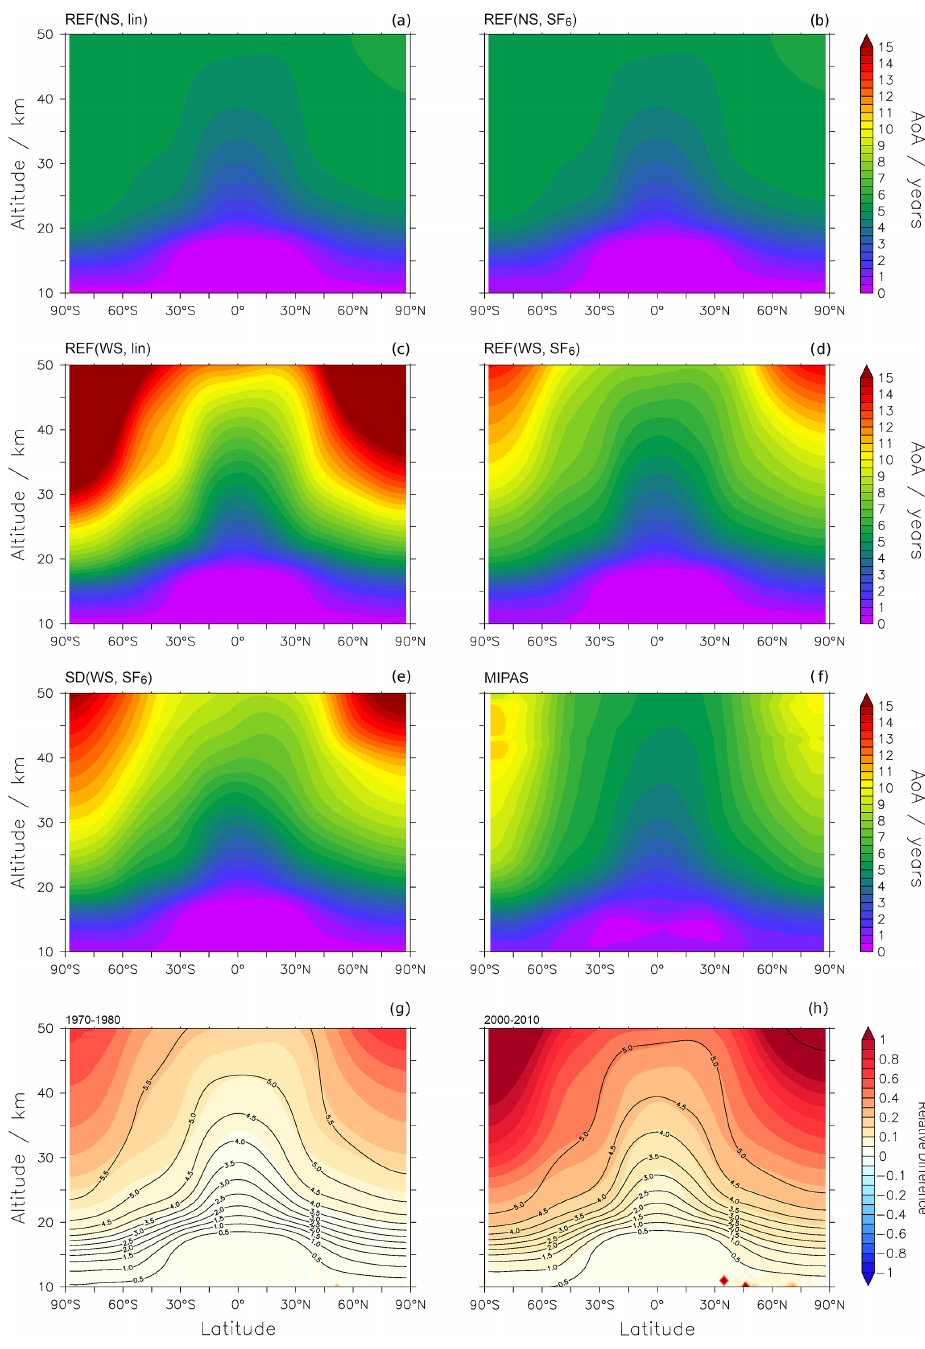
Figure 3. AoA climatologies of annual means over 2007–2010. Model AoA from the reference simulation for the different tracers, tr (NS, lin), tr (NS, SF 6 ), tr (WS, lin), and tr (WS, SF 6 ), is shown in panels (a) – (d) , respectively, while AoA ( tr (WS, SF 6 )) from the specified dynamics simulation is shown in panel (e) . MIPAS AoA (Stiller, 2021) can be seen in panel (f) . The relative difference between AoA(WS, SF 6 ) and AoA(NS, SF 6 ) from the reference simulation for the 1970–1980 and 2000–2010 periods is shown in panels (g) and (h) , respectively, − AoA(NS , SF 6 ) and is calculated using AoA(WS , SF 6 ) (where 1 = 100%). The black contours depict AoA(NS, SF 6 ) REF for the respective time AoA(NS , SF 6 )